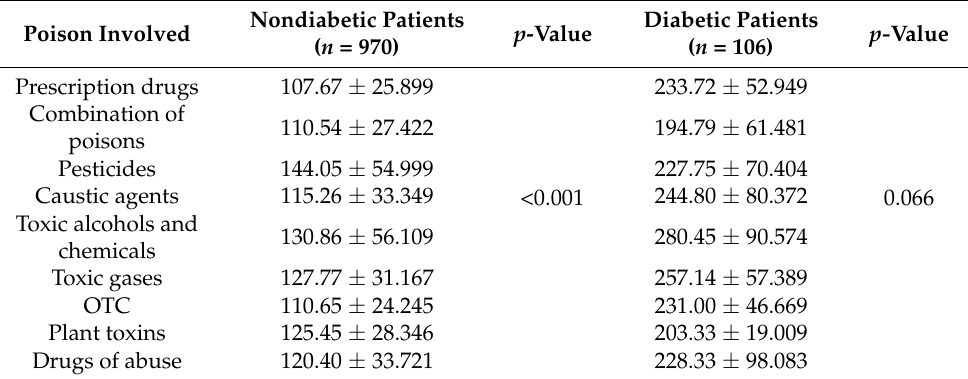
Table 2. Correlation between admission BGL with type of poison involved in nondiabetic and diabetic poisoned